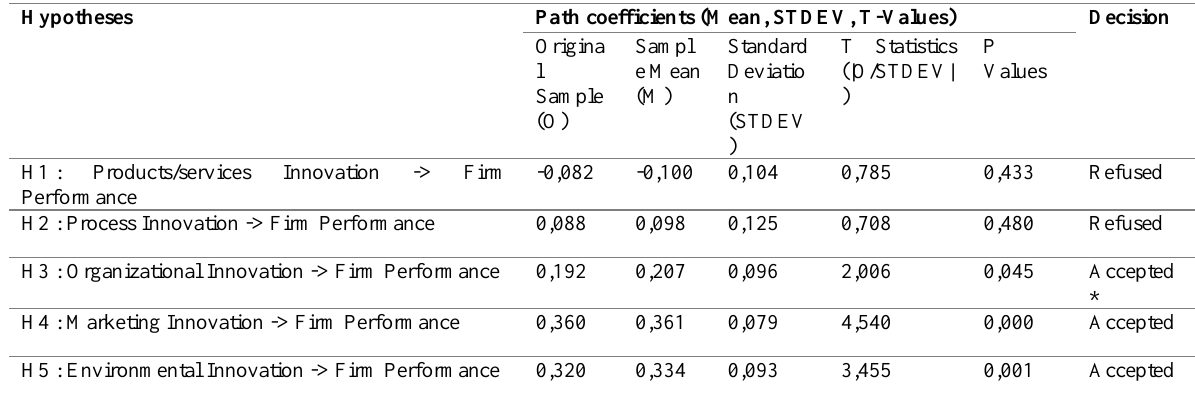
Table 8: Result of validation of research